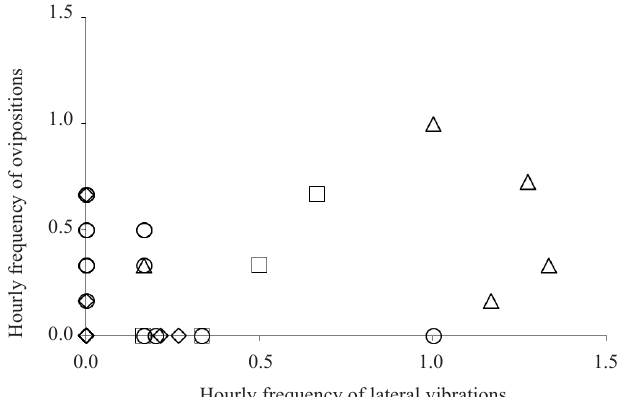
Fig 4. Relationship between hourly frequencies of ovipositing and lateral vibrations performed by the queen during one day. Circles, squares, diamonds, and triangles indicate colonies 3, 5, 6, and 9, respectively. Note that the queen of colony 6 performed neither ovipositing nor lateral vibration during one day on six